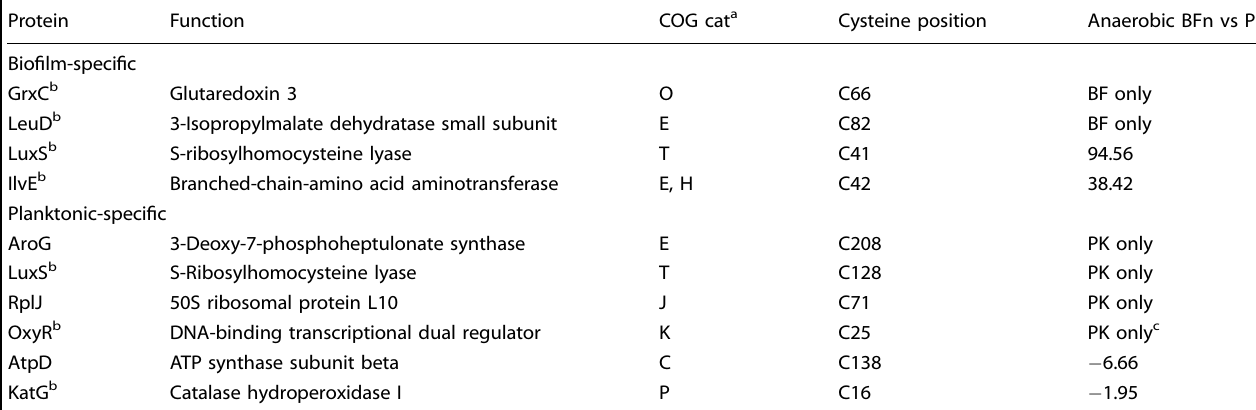
Table 3. List of cysteines identi fi ed to be differentially S -nitrosylated in anaerobically grown bio fi lm vs planktonic E. coli cultures by using the biotin-switch SILAC method.